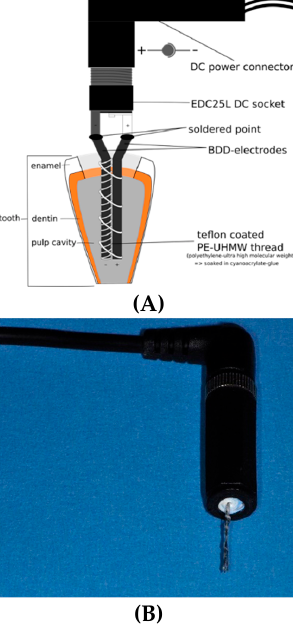
Figure 3. Prototype 2 boron-doped diamond (BDD) electrode used in this study, which can be inserted into a root canal ( A ): schematic representation; ( B ): actual prototype.